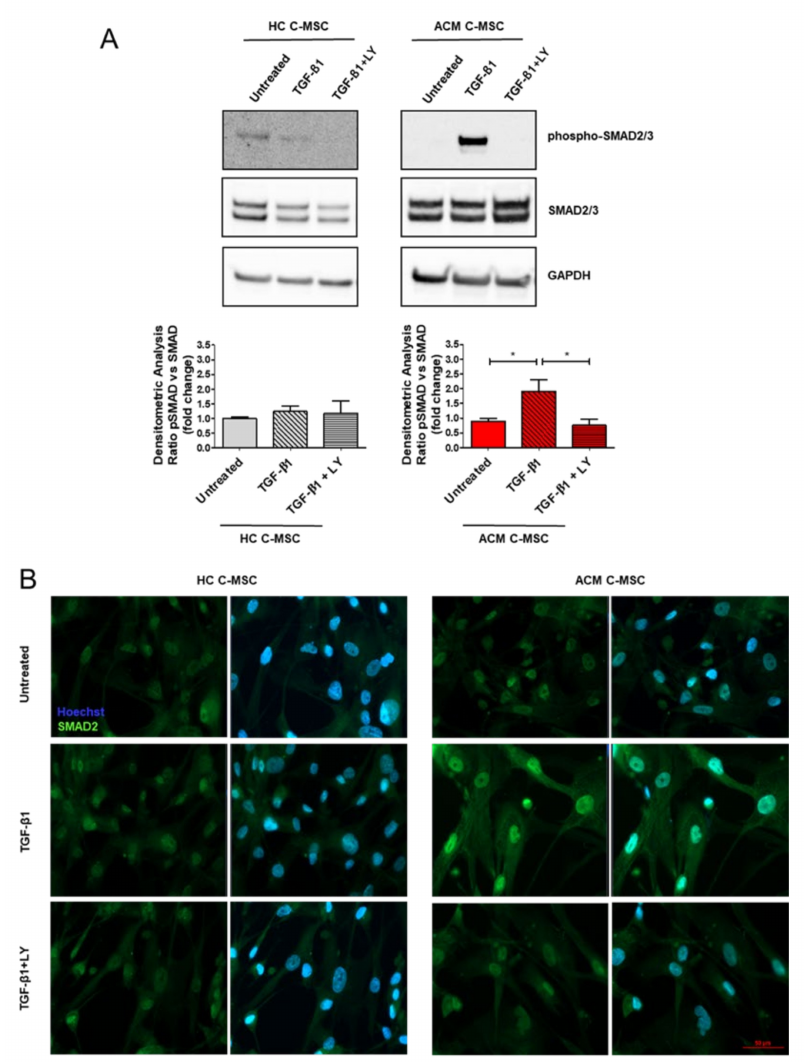
Figure 6. ACM C-MSC pro-fibrotic commitment depends on the TGF- β 1 canonical signaling pathway. Cardiac mesenchymal stromal cells isolated from HC donors and ACM patients were grown in low serum (2%) overnight and were stimulated or not with TGF- β 1 for 30 min in the presence or absence of LY364947 treatment. ( A ) Representative images of Western blot analysis on active phosphorylated form and total SMAD2/3 in total protein extracts of treated cells. Phospho-SMAD2/3 levels were corrected by total SMAD2/3 densitometry. Western blot data are presented as the fold change with respect to untreated target protein expression. The results are expressed as mean ± SEM ( n = 3/group). One-way ANOVA and Bonferroni’s post-test: * p < 0.05. ( B ) Representative images of immunostaining for SMAD2 to visualize nuclear translocation. Nuclei are stained with Hoechst 33342. Magnification is 40 × and the scale bar indicates 50 µ m ( n =